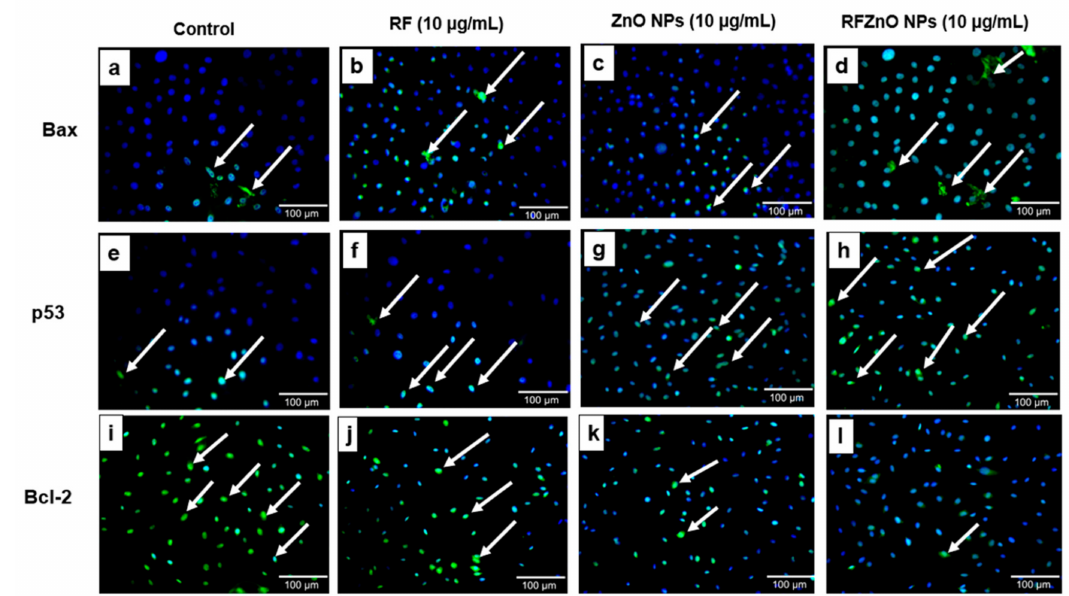
Figure 5. Immunofluorescence images of Bax ( a – d ), p53 ( e – h ), and Bcl-2 ( i – l ) in control and treated cells. Treated cells showed significant changes in the activity of apoptotic proteins. Control cells showed few p53- and Bax-positive cells and more Bcl-2-positive cells. Cells treated with Rubus fairholmianus (RF), zinc oxide nanoparticles (ZnO NPs), and R. fairholmianus capped zinc oxide nanoparticles (RFZnO NPs) showed higher levels of p53 and Bax positivity. The treatment with RF, ZnO NPs, and RFZnO NPs decreased Bcl-2. Magnification: 20X original; arrows indicate the presence of proteins p53, Bax, and Bcl-2 (FITC stained, green); nuclear stain: DAPI (blue). We also examined the level of these proteins by Western blotting (Figure 6a,b) and observed a similar pattern. From the immunoblot results, the levels of Bax and p53 pro-apoptotic proteins were high in cells treated with RFZnO NPs, while the level of anti-apoptotic protein Bcl-2 appeared to be low. The RFZnO NP-treated groups showed significantly increased levels ( p < 0.01) of Bax and p53, while reduced levels ( p < 0.01) of Bcl- 2 were observed. The activation of p53 and Bax leads to the loss of mitochondrial membrane potential and cyt c release, and immunofluorescence assays also support these findings.